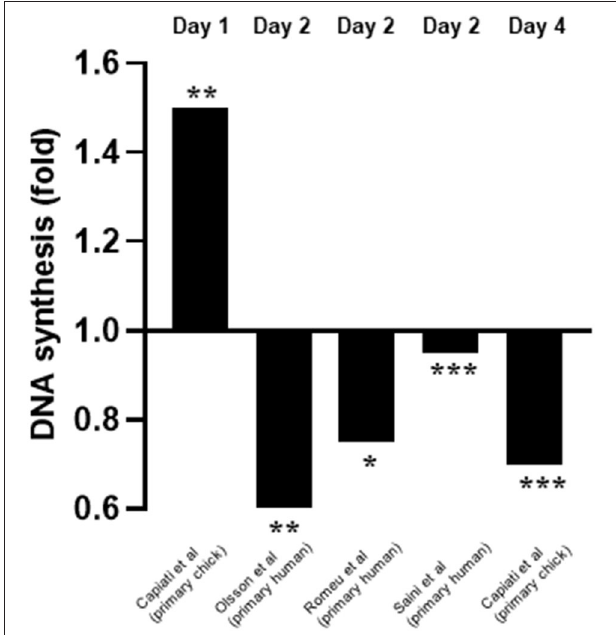
FIGURE 3 | Effect of 1,25(OH) 2 D 3 on DNA synthesis compared to untreated cells. The active form of vitamin D [1,25(OH) 2 D 3 ] at 10 − 7 M was used in all studies. * p < 0.05, ** p < 0.01, *** p < 0.001.